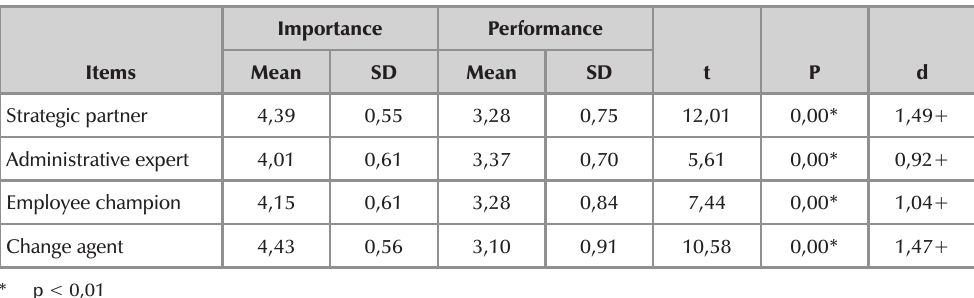
Paired samples statistics and t-test results for the line customers group (N =